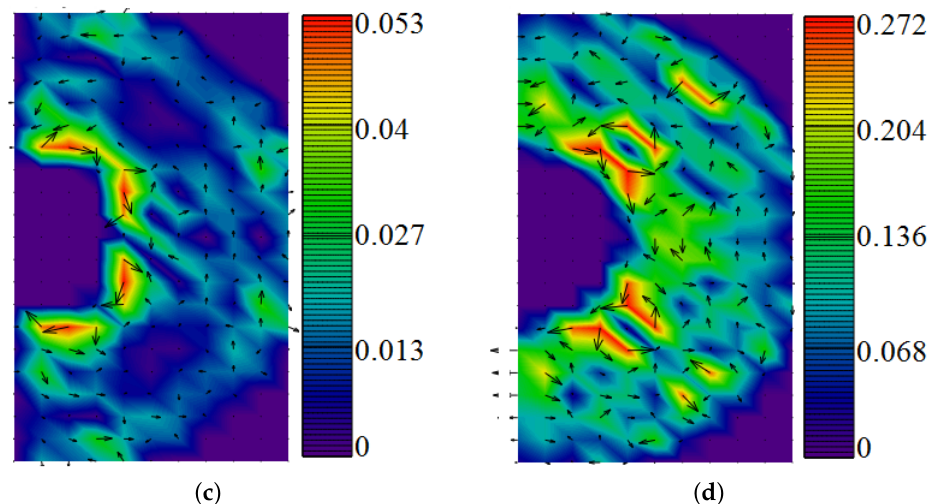
Figure 1. Numerical solution of Test Problem I: ( a ) the case of smooth boundary (the method of cells fullness); ( b ) the case of a stepped boundary between two media; ( c , d ) the difference between analytical and numerical solutions of the problem in the case of using partial cell fullness and in the case of a stepped boundary, respectively.